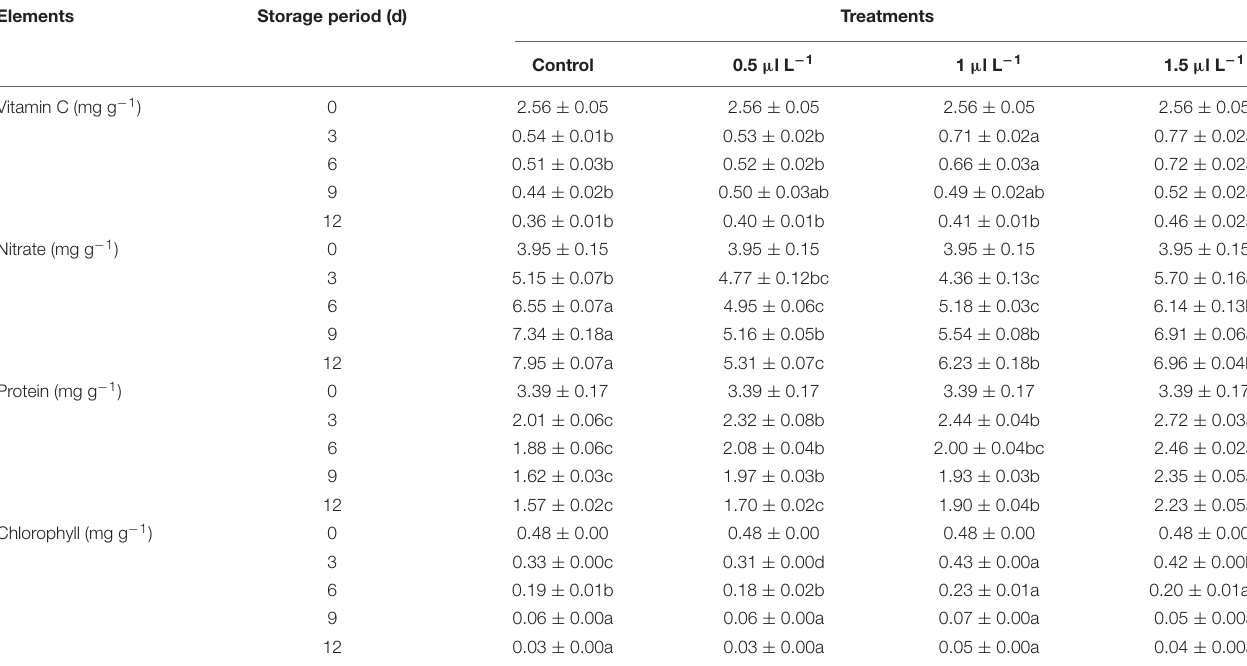
TABLE 1 | Changes in the vitamin C, nitrate, protein, and chlorophyll content of green mature “Hangjiao No.2” peppers treated with different concentrations of 1-MCP during storage at ambient temperature.